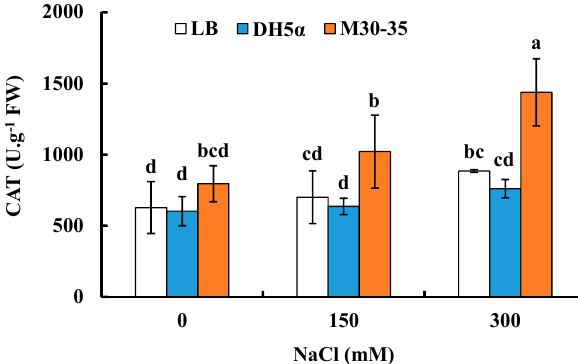
Figure 4. Effects of M30-35 on leaf catalase (CAT) activity of ryegrass under various salt treatment (0, 150 and 300 mM NaCl). Values are means and bars indicate SEs ( n = 12). Columns with different letters indicate significant differences among treatments at p < 0.05 (ANOVA and Duncan’s multiple comparison test).